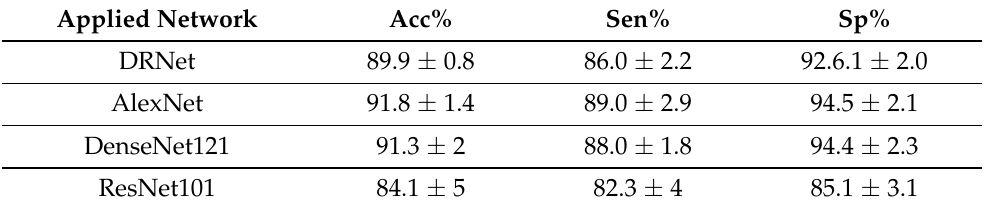
Table 4. Ten-fold comparisons for images composed of gray level and thickness map only. Applied